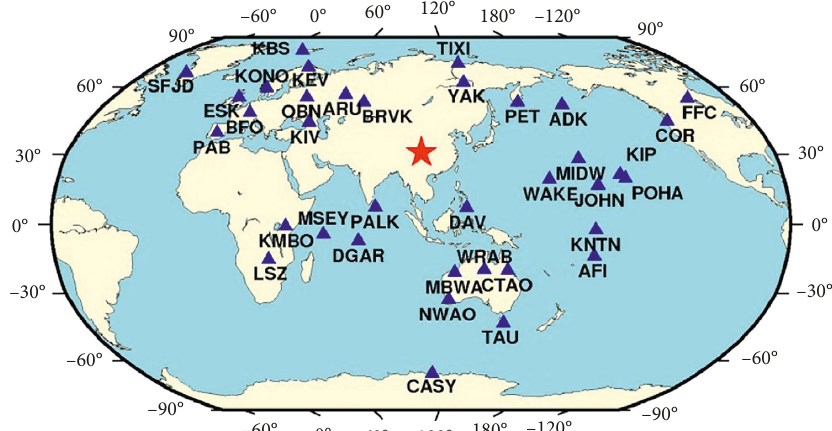
Figure 3: The epicenter and 36 teleseismic stations.